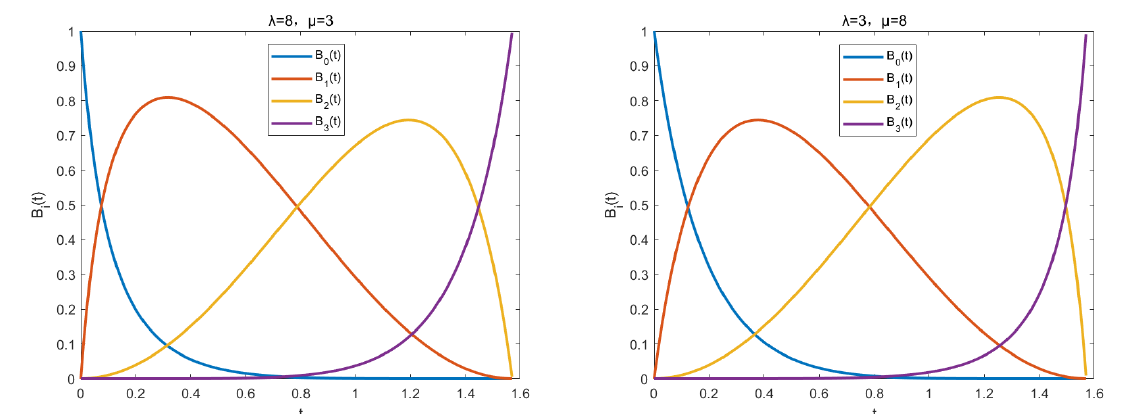
Figure 2. Some plots of the generalized quasi cubic trigonometric Bernstein basis functions with α ( t ) and β ( t ) given in Equation (7) and p = q =